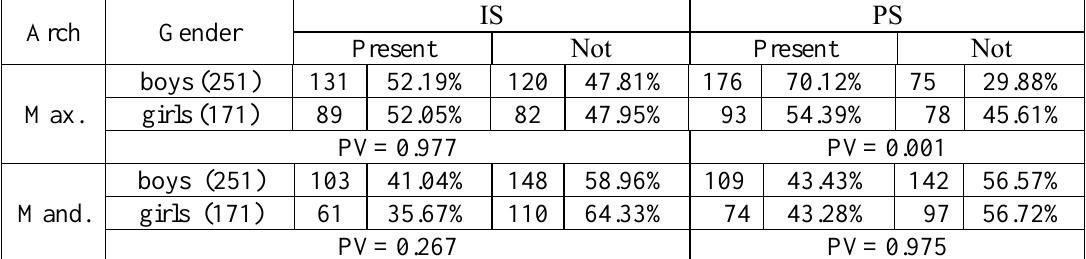
Table 4: gender differences in the presence of IS and PS in both maxillary and mandibular